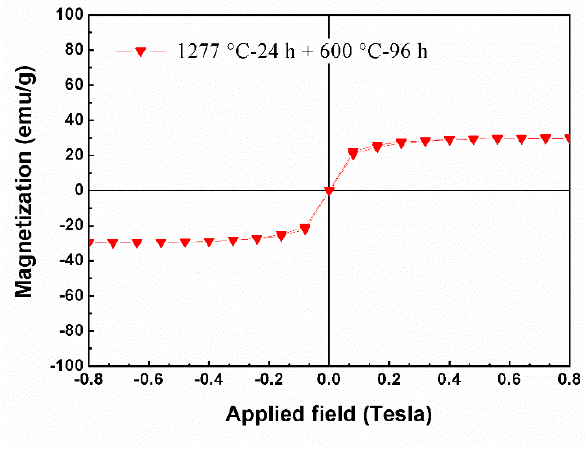
Figure 6. Hysteresis loop of FeNiCoAlTiNb samples with different aging conditions: ( a ) As-prepared samples, ( b ) 1277 °C—24 h, ( c ) 1277 °C—24 h + 600 °C—12 h, ( d ) 1277 °C—24 h + 600 °C—24 h, ( e ) 1277 °C—24 h + 600 °C—48 h, ( f ) 1277 °C—24 h + 600 °C—72 h, and ( g ) 1277 °C—24 h + 600 °C—96 h.